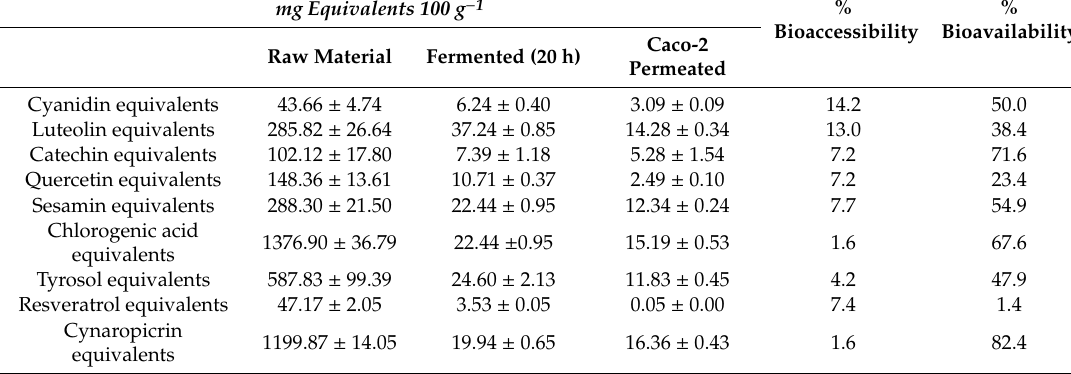
Table 2. Semiquantitative values for sesquiterpene lactones and for the di ff erent subclasses of phenolic compounds (expressed as mg / 100g) from UHPLC-QTOF-MS considering the raw (undigested) material, fermented samples and Caco-2 permeated fraction. Bioaccessibility and bioavailability are provided as %